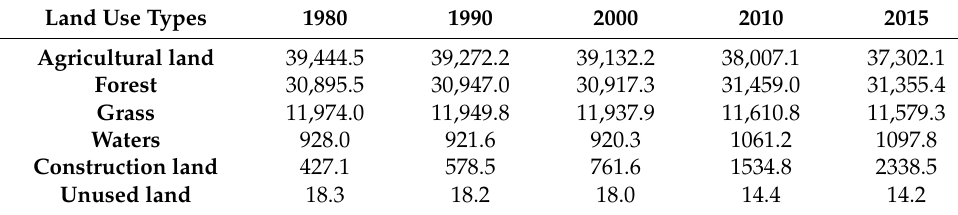
Figure 4. LULC maps in Chongqing (1980, 1990, 2000, 2010, 2015). Source: edited by the authors. Table 1. Statistics of LULC in Chongqing (unit: km 2 ) (1980, 1990, 2000, 2010,